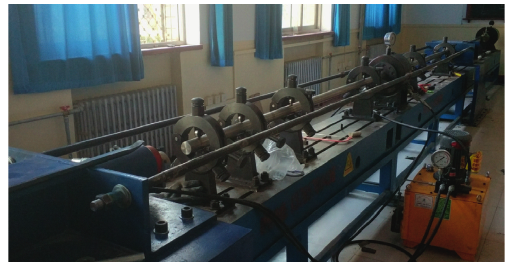
Figure 9: SHPB test equipment.